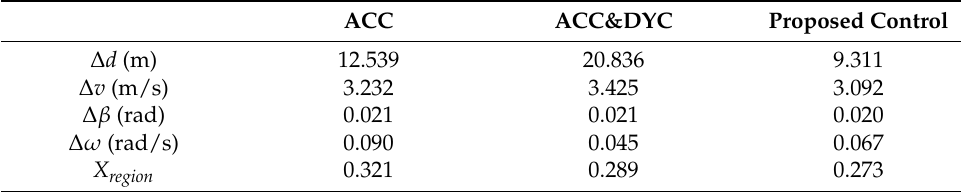
Figure 16. X region and adjustment factors: ( a ) X region ; ( b ) adjustment factors. Table 2. Maximum errors and X region with the three controllers.